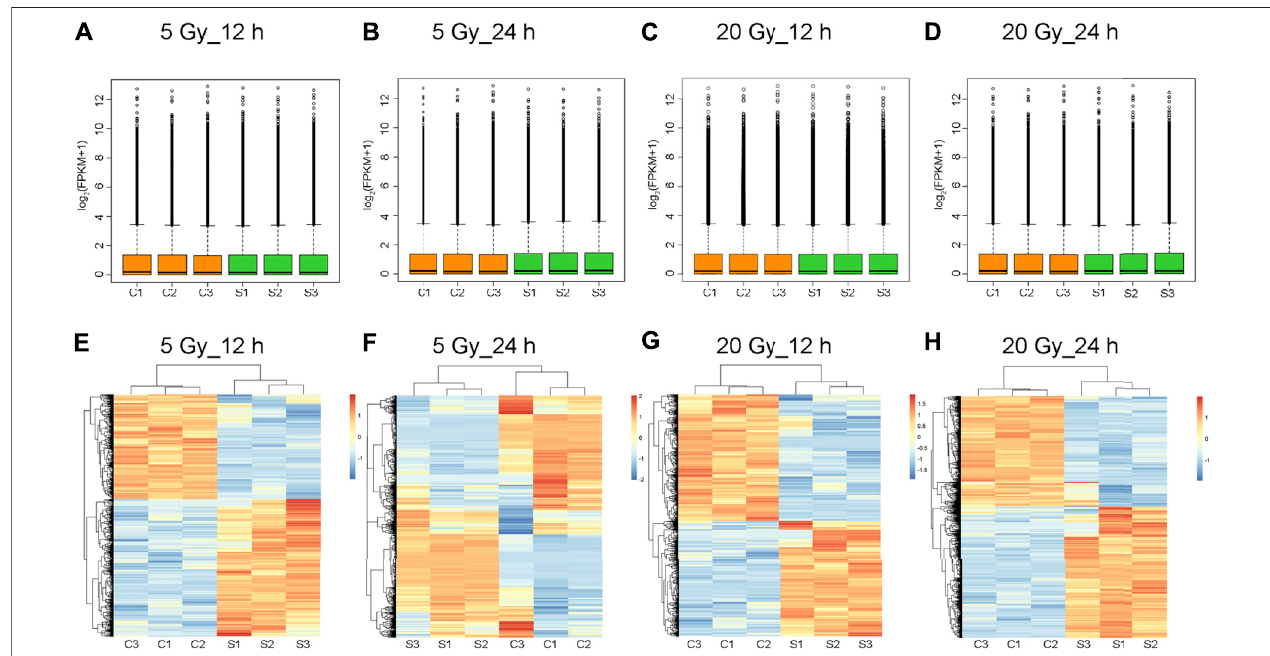
FIGURE1| Totalexpression levels andclusteranalysisoftranscripts. (A – D) Overalltranscript expression levels. C1,C2,and C3representcontrolgroups; S1,S2, and S3, x-ray – treated groups; FPKM, fragments per kilobase of exon model per million reads mapped. (E – H) Transcripts differentially expressed in brain microvascular endothelial cells exposed to the indicated x-ray dose compared with unexposed control cells; 12 h or 24 h is the time after x-ray exposure. Clustered heatmaps show combinations of transcripts with similar natures. Red indicates high expression level; blue, low expression. Log 2 (FPKM + 1) values are scaled to different color